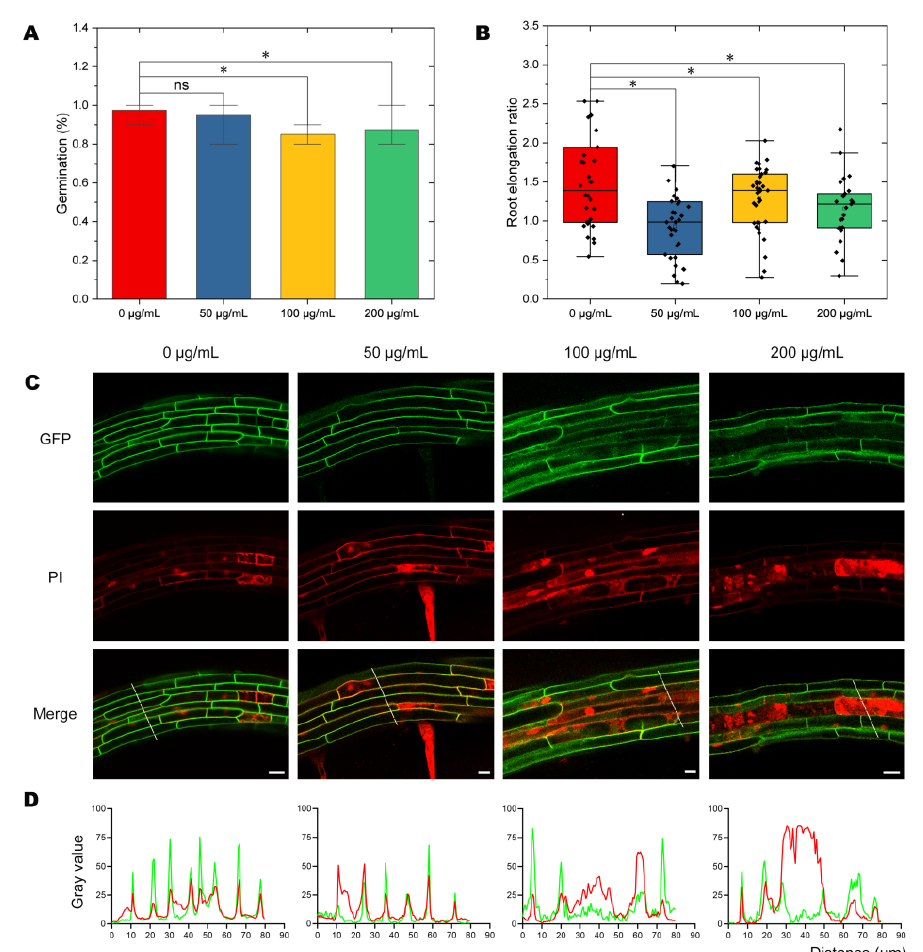
Figure 1. Exposure to PVC NPs alters seed germination and plant growth. ( A ) Seed germination rate after 72 h of exposure to PVC NPs. ( B ) Root elongation rate after 7 d of exposure to PVC NPs. Black dots represent the number of replicates. Seedlings of Arabidopsis thaliana , ecotype Columbia-0 grown on plates were analyzed in (A,B). ( C ) Integrity assay of root cortex tissues exposed to different concentrations of PVC NPs. Seedlings expressing GFP-LTi6a, which is an integral plasma membrane protein, were stained by PI. ( D ) Plot of intensity values along the white line in (C). The green curve represents the gray value of GFP fluorescence, and the red curve represents the gray value of PI fluorescence. Differences calculation using t -test were considered significant at p < 0.05, as indicated by *. “ns” means “no significant difference”. n ≥ 30 seedlings in A and B. Scale bars = 20 μ m.